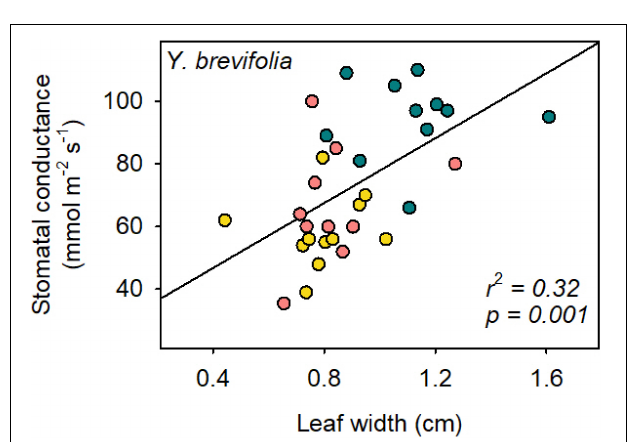
FIGURE 6 | Leaf width correlates with stomatal conductance in Y. brevifolia . The r 2 - and p -value of the organized least square regression is provided in the panel. Stomatal conductance = 52 × leaf width + 26. Yellow, south-eastern slope; Blue, alluvial fan; Pink, north-western slope. n = 9–11 leaves per species per